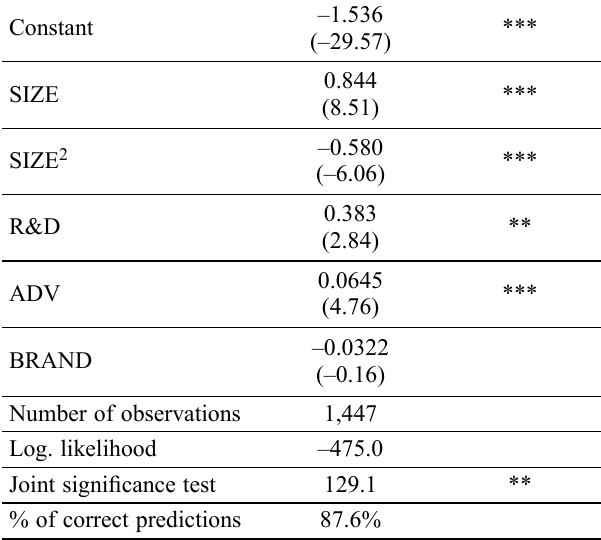
Table 3. Probit estimation on existence of foreign